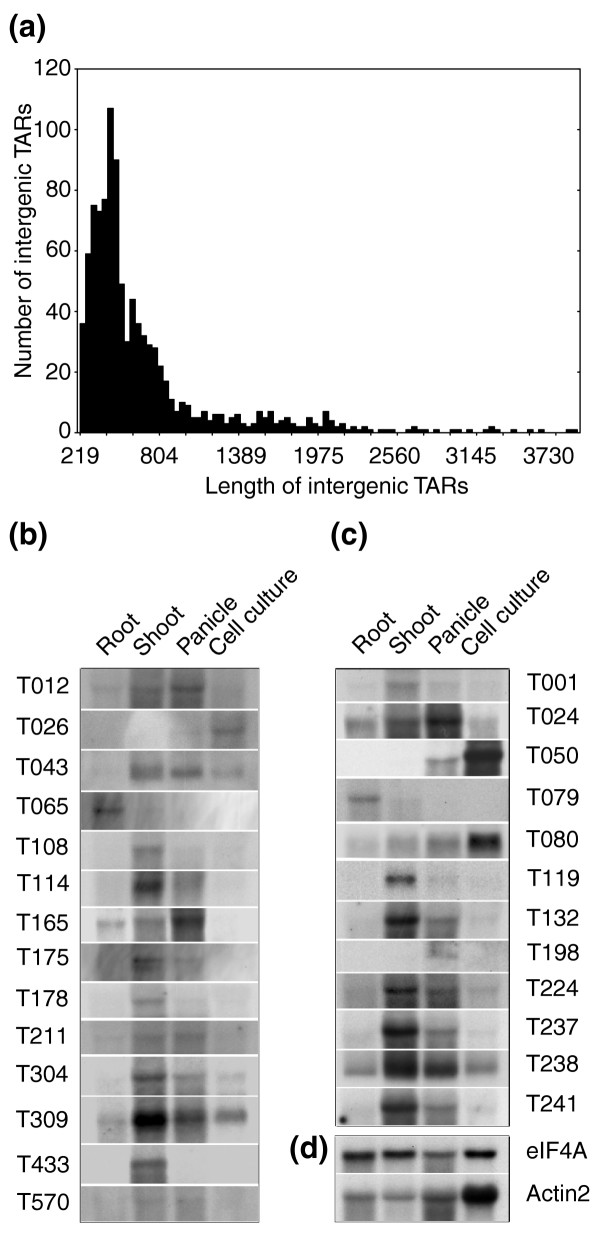
Analysis of intergenic TARs of japonica chromosome 10. (a) The 988 japonica chromosome 10 intergenic TARs distributed by length. (b) RNA gel blotting analysis of selected japonica intergenic TARs. Probes for the intergenic TARs shown in this panel were derived from corresponding PCR-amplified TAR sequences from japonica rice genomic DNA. (c) Probes shown in this panel were derived from RT-PCR amplification of the corresponding TARs from poly(A)+ RNA. (d) The rice cDNAs for eIF4A and actin2 were used as loading controls. 5 μg of RNA from the four sources - root, shoot, panicle, and suspension cell culture - that were used for probing tiling microarrays were used for RNA blot analysis here.